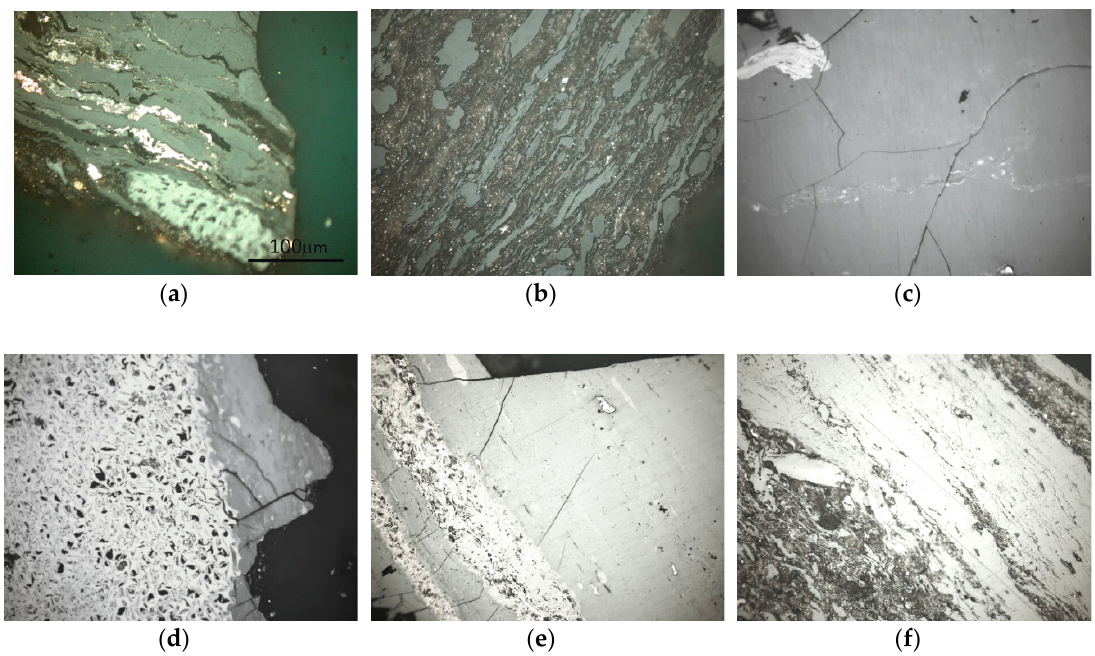
Figure 2. ( a ) Low-rank coal—a part of coal made of vitrinite, inertinite, and liptinite macerals, as well as smudges of mineral matter; ( b ) low-rank coal—carbominerite part—mineral matter (loam)